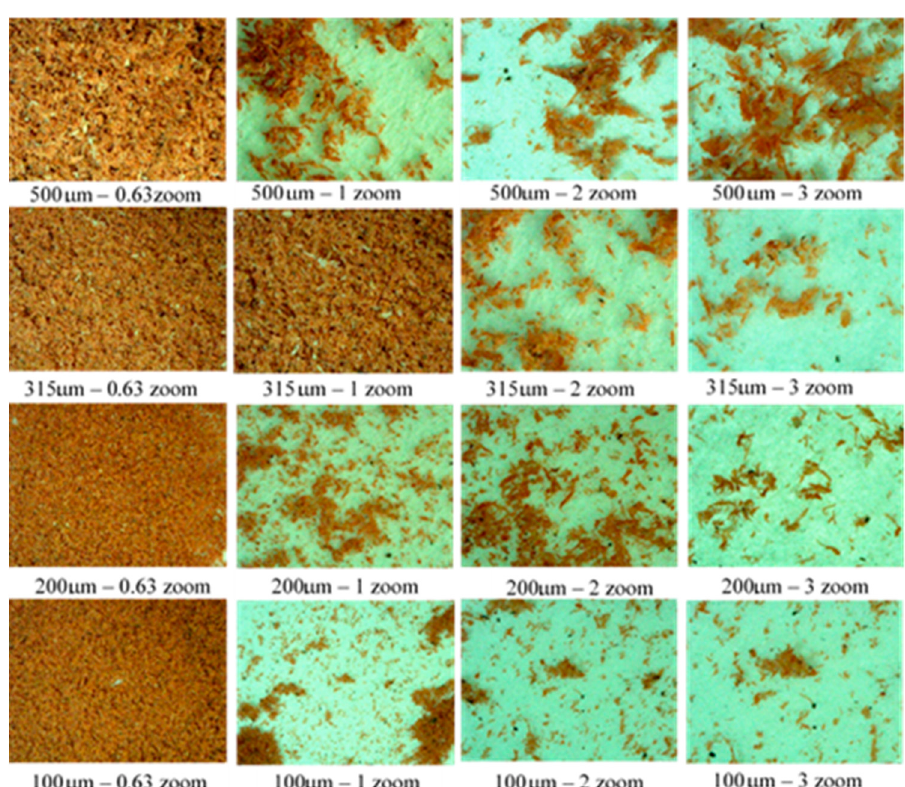
Figure 5. Padauk dust particles and their shape.